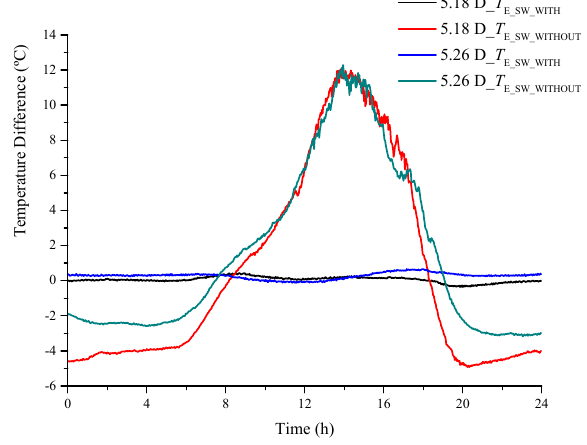
Figure 12. Comparison of temperature difference between exterior and interior surfaces of the